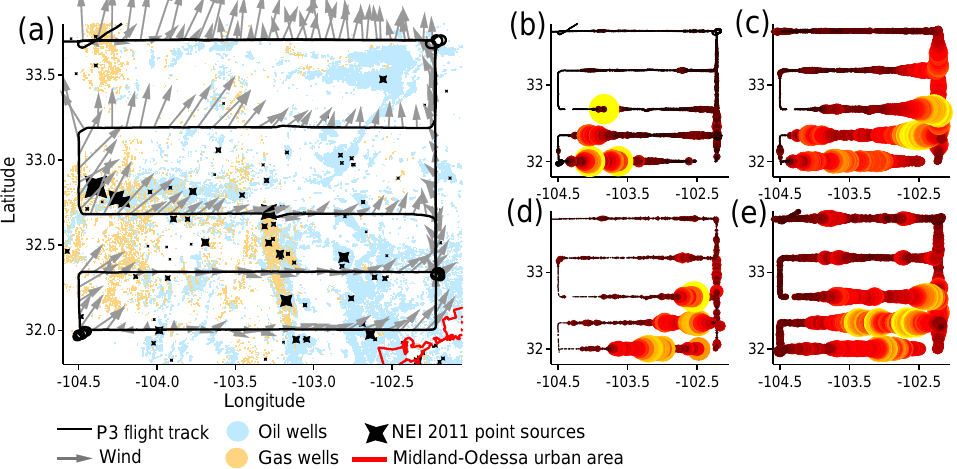
Figure 2. (a) 23 April flight track; wind direction; locations of oil and gas wells, NEI 2011 point sources, and the Midland–Odessa urban area. NEI point sources are sized by total reported VOC emission, ranging in the area shown from 0 to 400tyear − 1 . (b) Flight track colored and sized by toluene (0–1.7ppbv). (c) Flight track colored and sized by acetaldehyde (0–3.6ppbv). (d) Flight track colored and sized by H 2 S (0–8ppbv). (e) Flight track colored and sized by m/z 71.049 C 4 H 6 OH + (0–86 normalized counts per